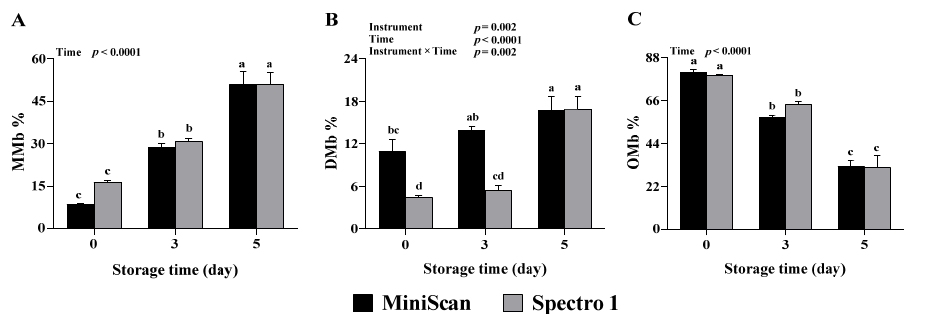
Figure 3. Surface metmyoglobin% (MMb%; ( A )), deoxymyoglobin% (DMb%; ( B )), and oxymyoglo- bin% (OMb%; ( C )) values obtained from beef steaks at 0, 3, and 5 days of storage using Spectro 1 and MiniScan ( n = 12). Data are least-squares mean ± SE. a–d Means lacking a common letter differ significantly ( p ≤ 0.05).